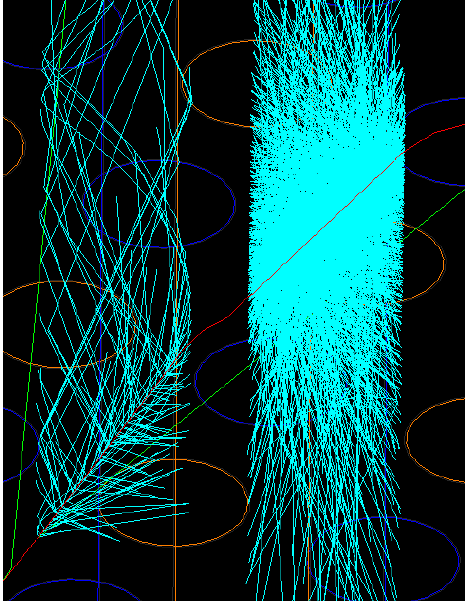
Figure 2. Optical physics simulated with GEANT4. The red line from the bottom left to the upper right indicates the electron from the shower fragment. The green line is a low-energy photon from the radiation, and cyan lines are optical photons generated from Cherenkov and scintillation process on the left and right sides, respectively. Blue and orange lines represent a sectional view of Cherenkov and scintillation